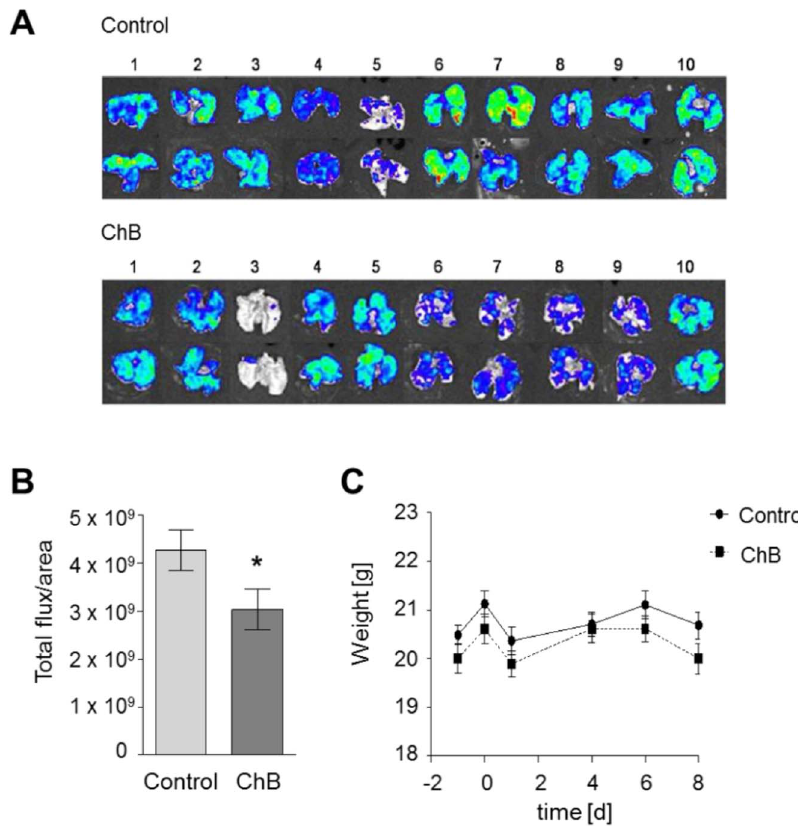
Figure 1. Chondramide diminishes metastasis invivo . 1 6 10 5 4T1-Luc cells were injected intravenously into pretreated (0.5 mg/kg ChB) and untreated BALB/cByJRj mice. (A) 8 days after cell inoculation mice were sacrificed, lungs were harvested and used for recording bioluminescence signals. Each lung was imaged from the dorsal and ventral side. Color bar scales were equalized. (B) Quantitative evaluation of metastasis to the lungs. Region of interest were defined (ROI) and total luciferin signal in ROIs was calculated as photons/second/cm 2 (total flux/area). Ten lungs per group, *, p , 0.05 (t-test, unpaired). (C) Mouse weight over treatment period. Weight of treated (ChB) and untreated (DMSO) mice from day of cell inoculation (day 0) to euthanasia (day8) is shown for each group.